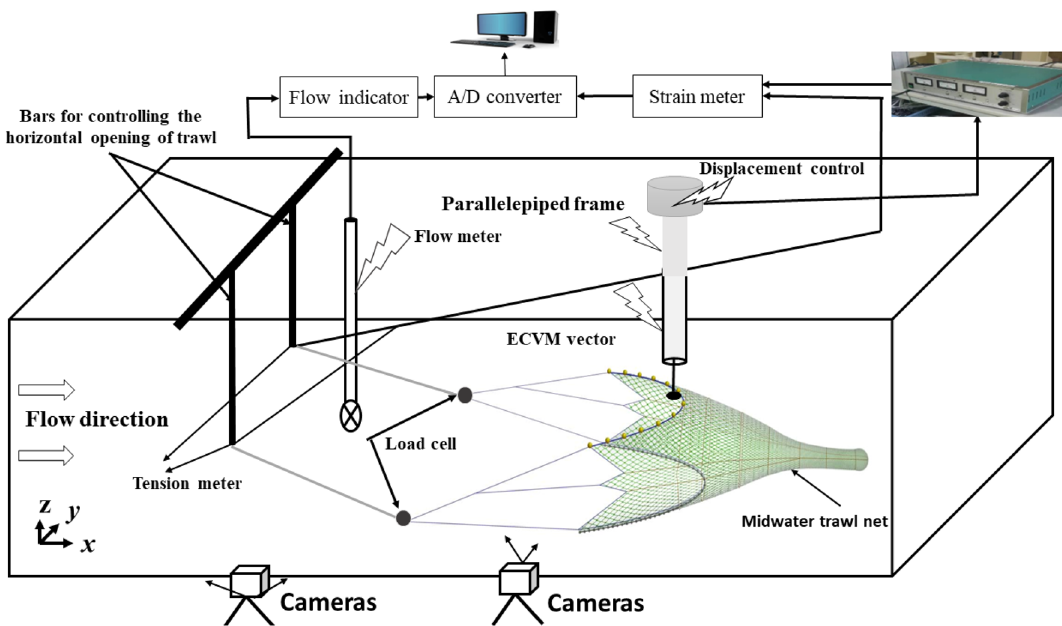
Figure 3. Experimental process of the scale model of the krill trawl tested in the flume tank.